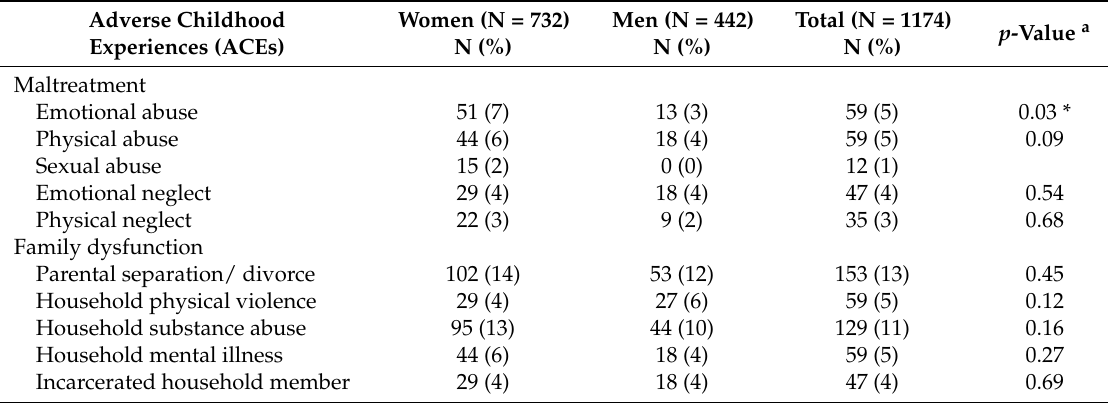
Table 3. Reported prevalence of ACEs in the sample and by gender.